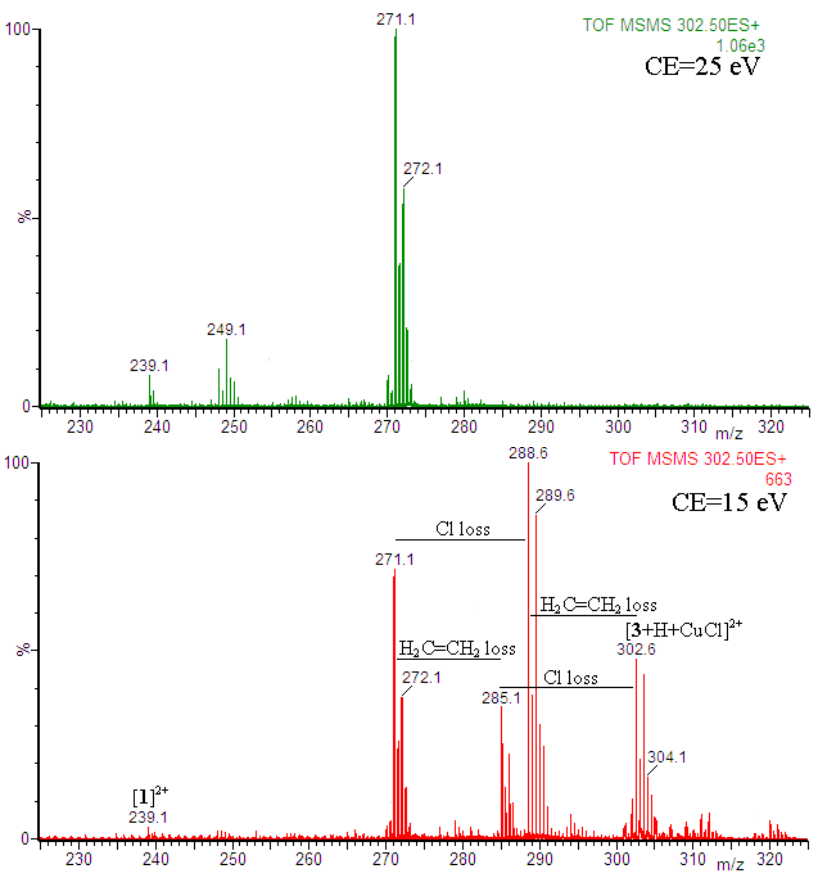
Figure 5: CID-MS/MS spectra of [ 3 +H+CuCl] 2+ ion shown in the m/z range of interest. At collision energy of 15 eV, there is abundant fragment ion formed by the loss of an ethylene molecule from [ 3 +H+CuCl] 2+ ion. At collision energy of 25 eV, the fragment ion at m/z 239, which may be assigned as [ 1 ] 2+ is quite abundant. ,